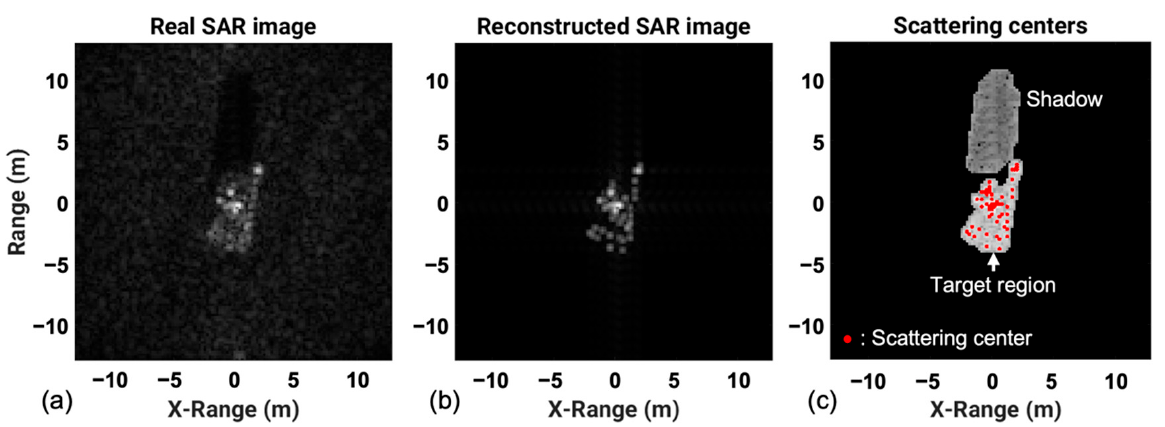
Figure 3. Examples of scattering centers extracted using CLEAN: ( a ) SAR image, ( b ) reconstructed SAR image, and ( c ) extracted scattering centers with the segmentation results.